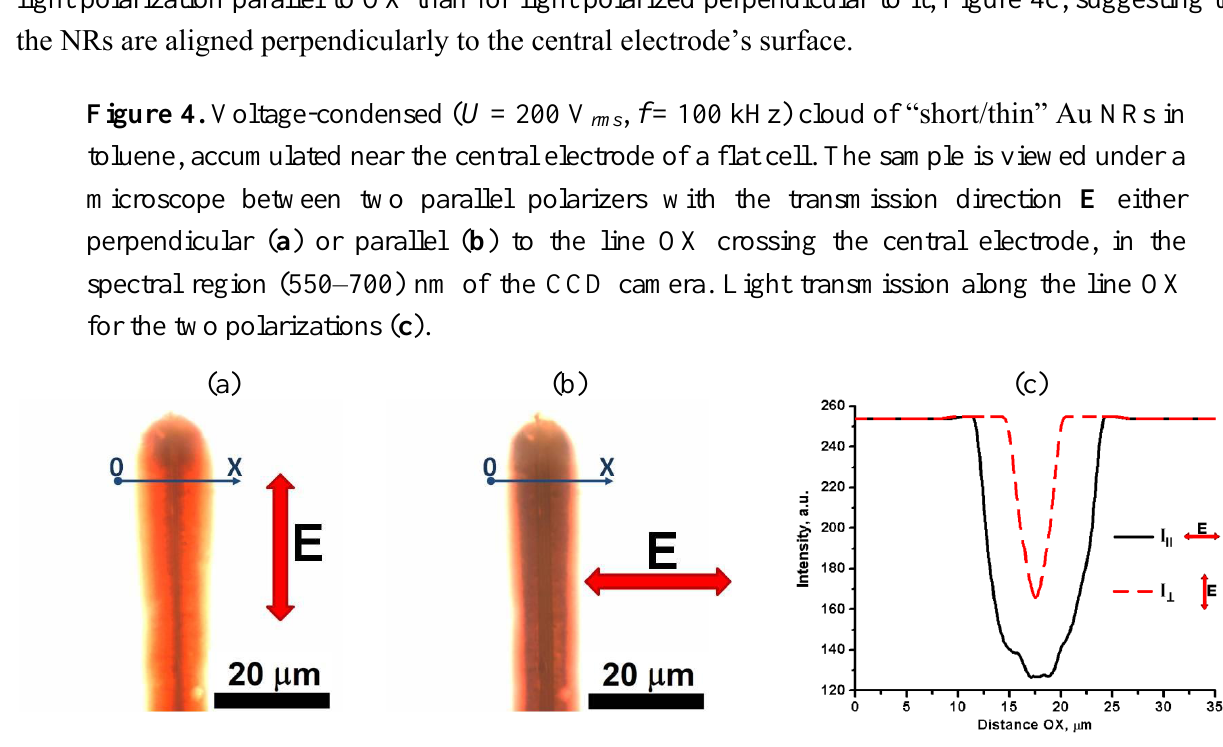
Figure 4. Voltage-condensed ( U = 200 V